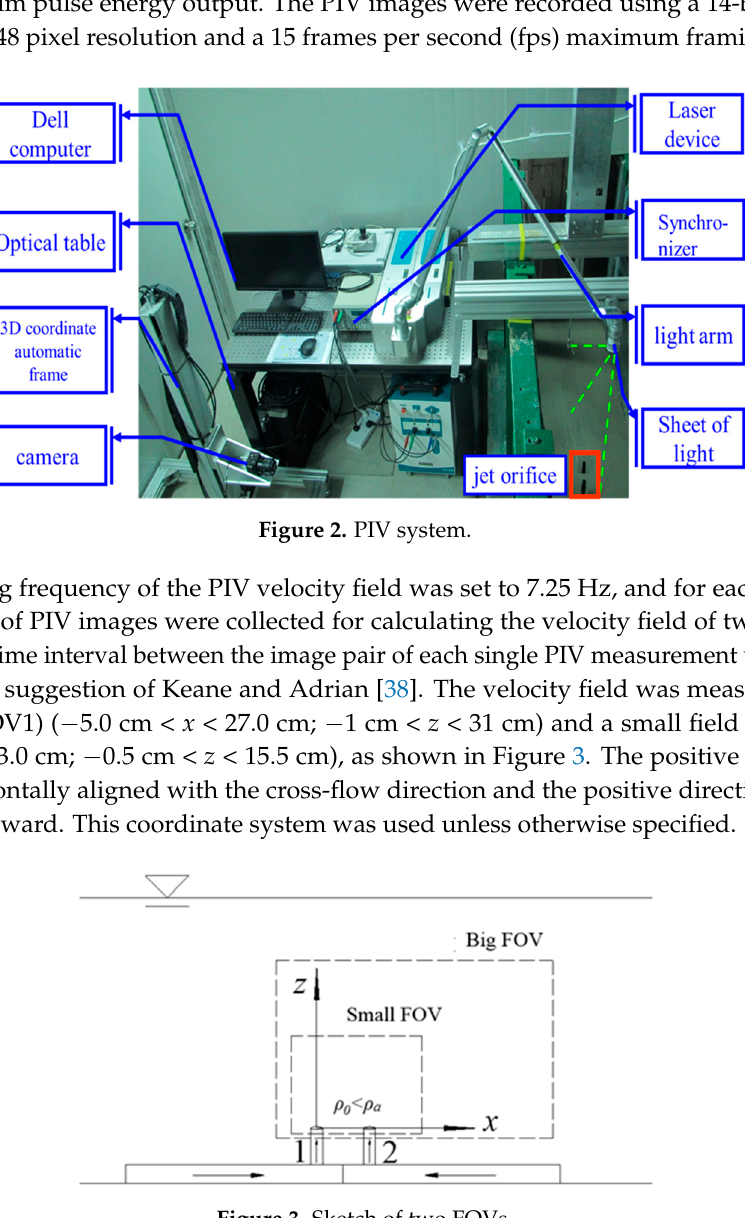
Figure 3. Sketch of two FOVs.